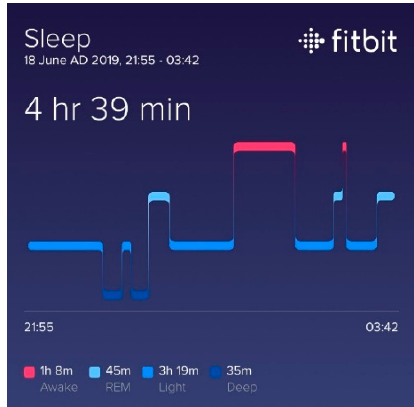
Figure A3. Bangkok,